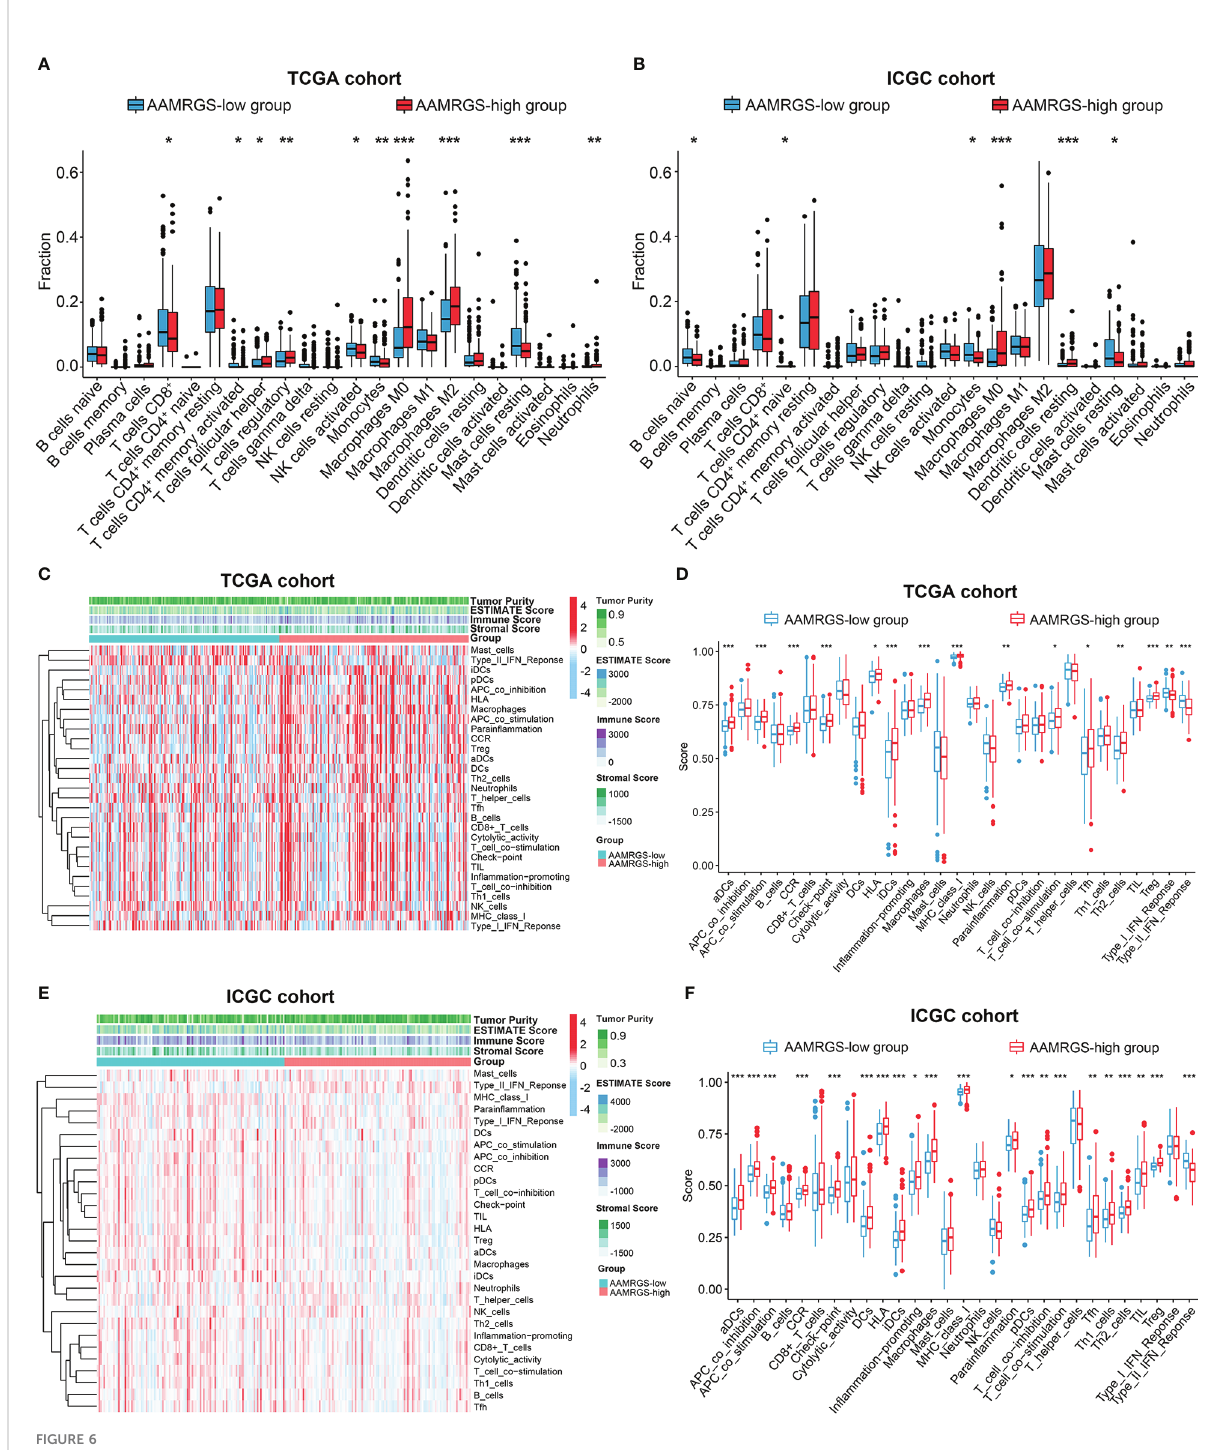
FIGURE 6 The differences in immune cell in fi ltration and immune function between the different AAMRGS subgroups. (A) The abundance of immune cells in the AAMRGS subgroups in the TCGA cohort. (B) The abundance of immune cells in the AAMRGS subgroups in the ICGC cohort. (C) Heatmap of the 29 immune-related gene sets enriched among the AAMRGS-high and AAMRGS-low groups in the TCGA cohort. (D) Differences in immune function among the two AAMRGS subgroups in the TCGA cohort. (E) Heatmap of the 29 immune-related gene sets enriched among the AAMRGS-high and AAMRGS-low groups in the ICGC cohort. (F) Differences in immune function among the two AAMRGS subgroups in the ICGC cohort. * P < 0.05, ** P < 0.01, *** P <